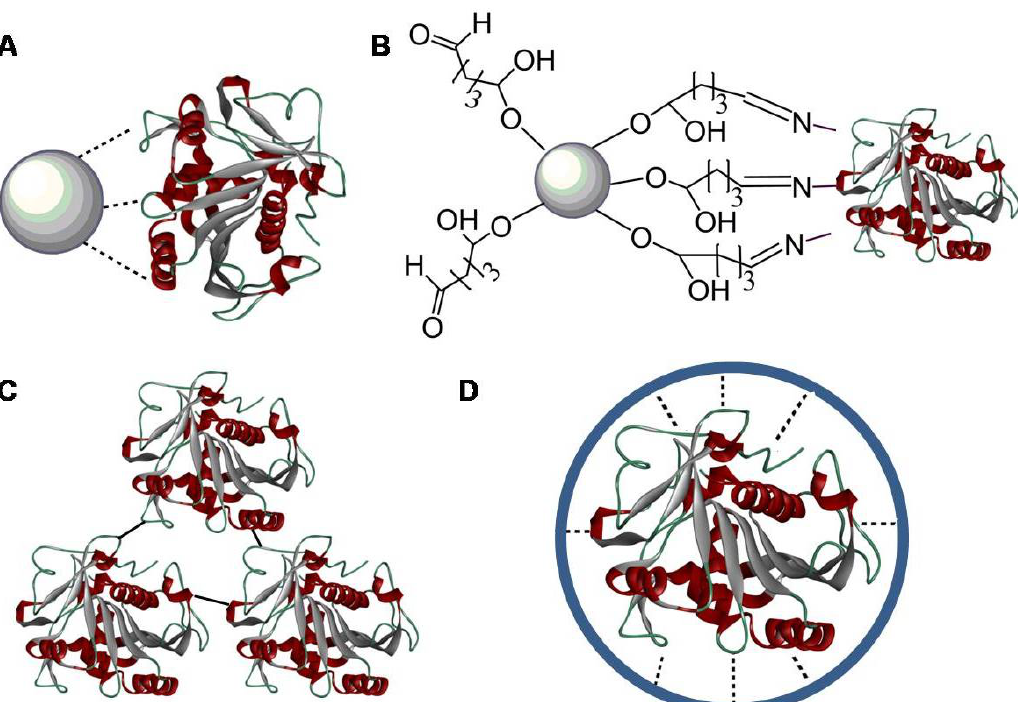
Figure 4. Enzyme stabilization by immobilization introduces additional covalent and non-covalent forces to an external matrix. ( A ) Non-covalent physical adsorption of an enzyme on the nanoparticle; ( B ) covalent binding of an enzyme to the nanoparticle (multipoint attachment); ( C ) covalent crosslinking of enzymes; and ( D ) microencapsulation of an enzyme by a